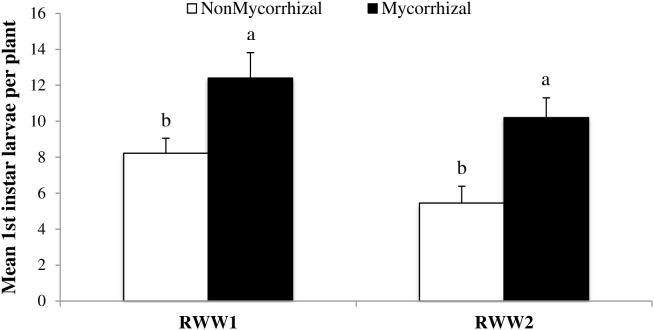
Mean number of Lissorhoptrus oryzophilus larvae per plant (± SE) in a greenhouse experiment using mycorrhizal (M) and nonmycorrhizal (NM) rice plants of the variety ‘Cocodrie.’ Plants were infested with pairs of rice water weevil adults to feed on each plant for 5 days. NonMycorrhizal: rice seeds + sterilized AMF, Mycorrhizal: rice seeds + live AMF. Bars and lower case letters at the column head indicate that means differ significantly (LSD, P ≤ 0.05).